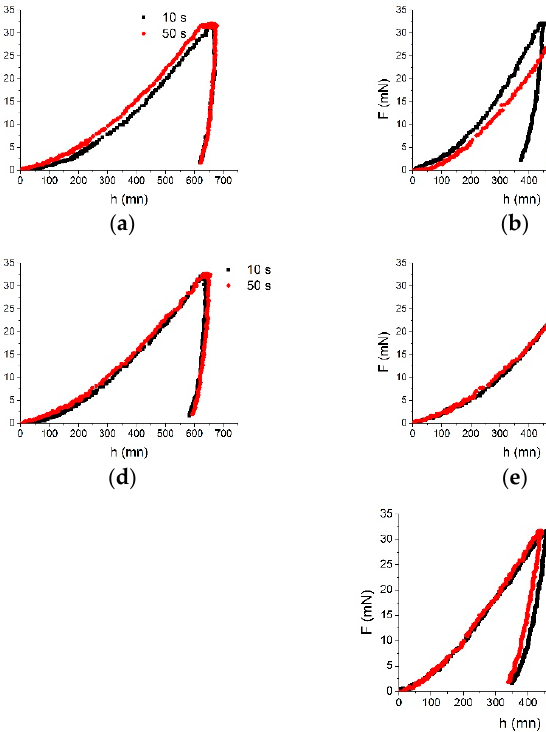
Figure 9. Summarized structure of Hastelloy X–Palnicro 36M brazed joint designed for mechanical testing.